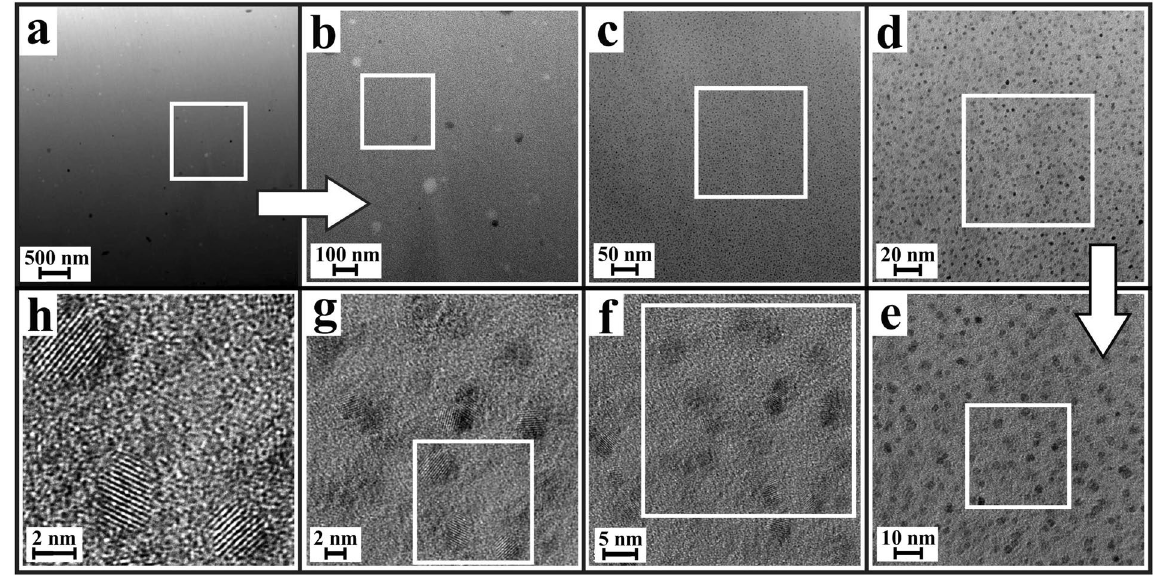
Figure 6. TEM bright field micrographs of a LAS glass sample thermally treated at 725 °C for t = 24 h. ( a , b ) At low magnifications, the LAS crystals with comparatively low volume density and crystal diameters of up to approximately 50 nm are visible. ( c – h ) With increasing magnification, the dense network of nanocrystalline ZrO 2 precipitations gets